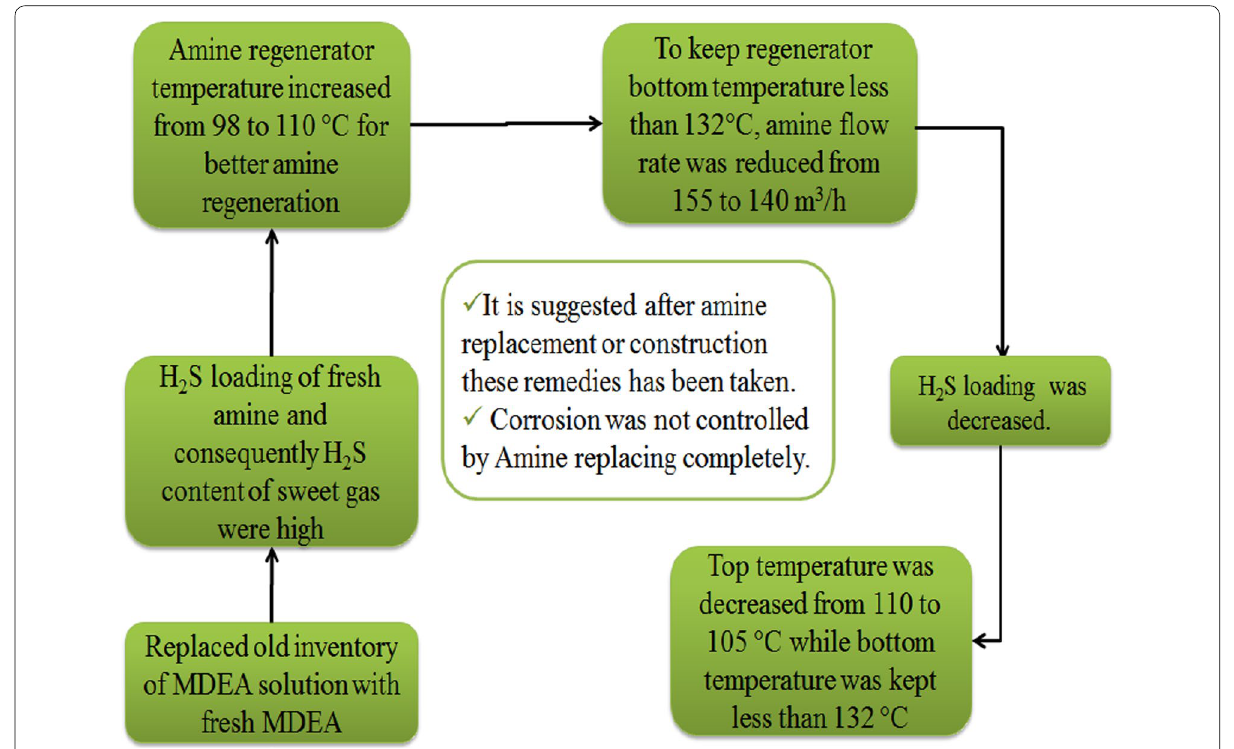
Fig. 14 Operational remedies after total amine